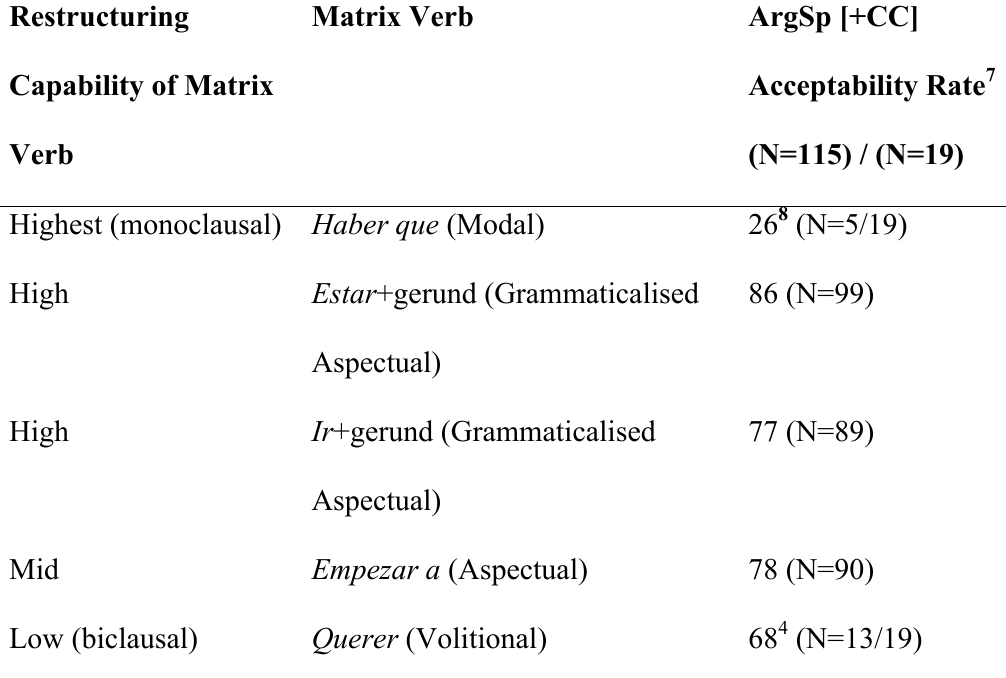
Table 2 . Percentage acceptability of CC with verbs with different restructuring